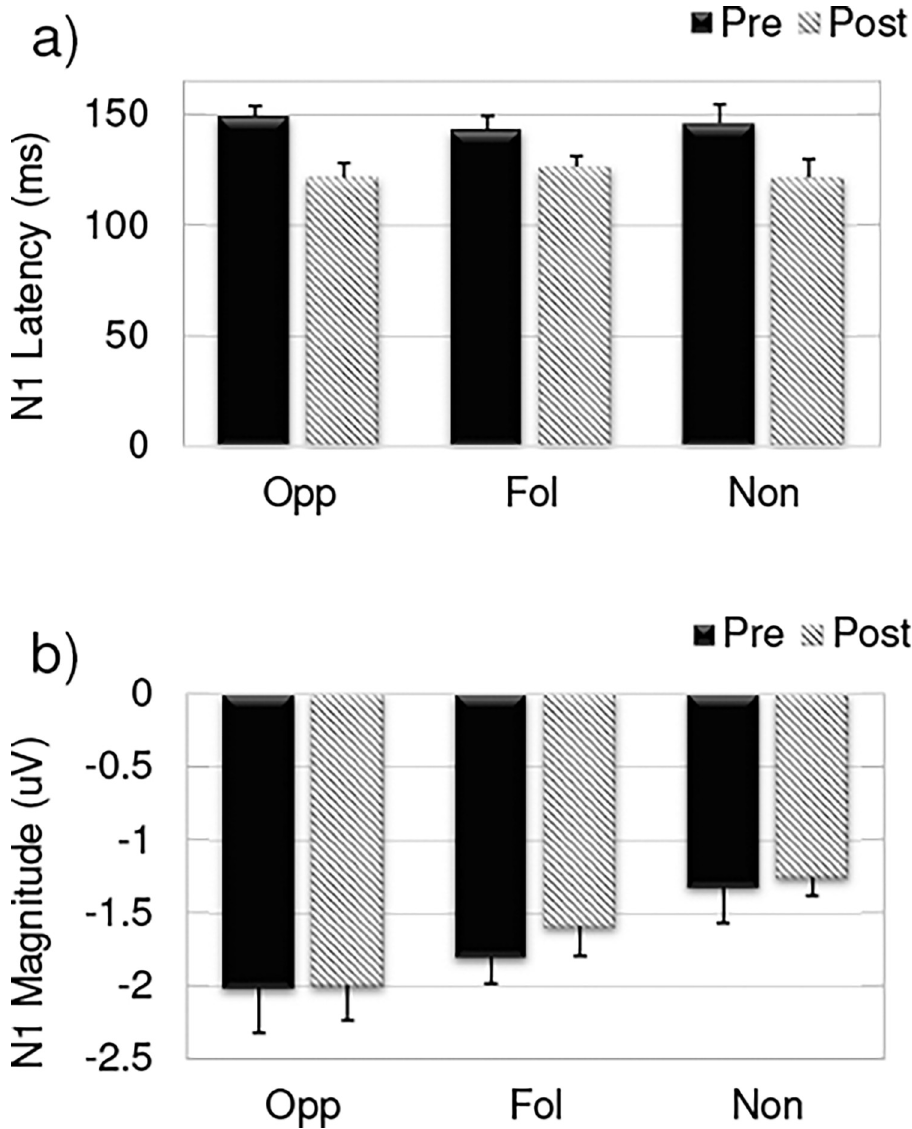
Fig 4. N1 latency and amplitude. The a) mean N1 peak latency and b) mean N1 peak amplitude from the ERPs at Cz for the opposing (Opp), following (Fol), and non-varying (Non) groups pre-training (solid bars) compared to post- training (slanted lines). Bars represent standard error of the